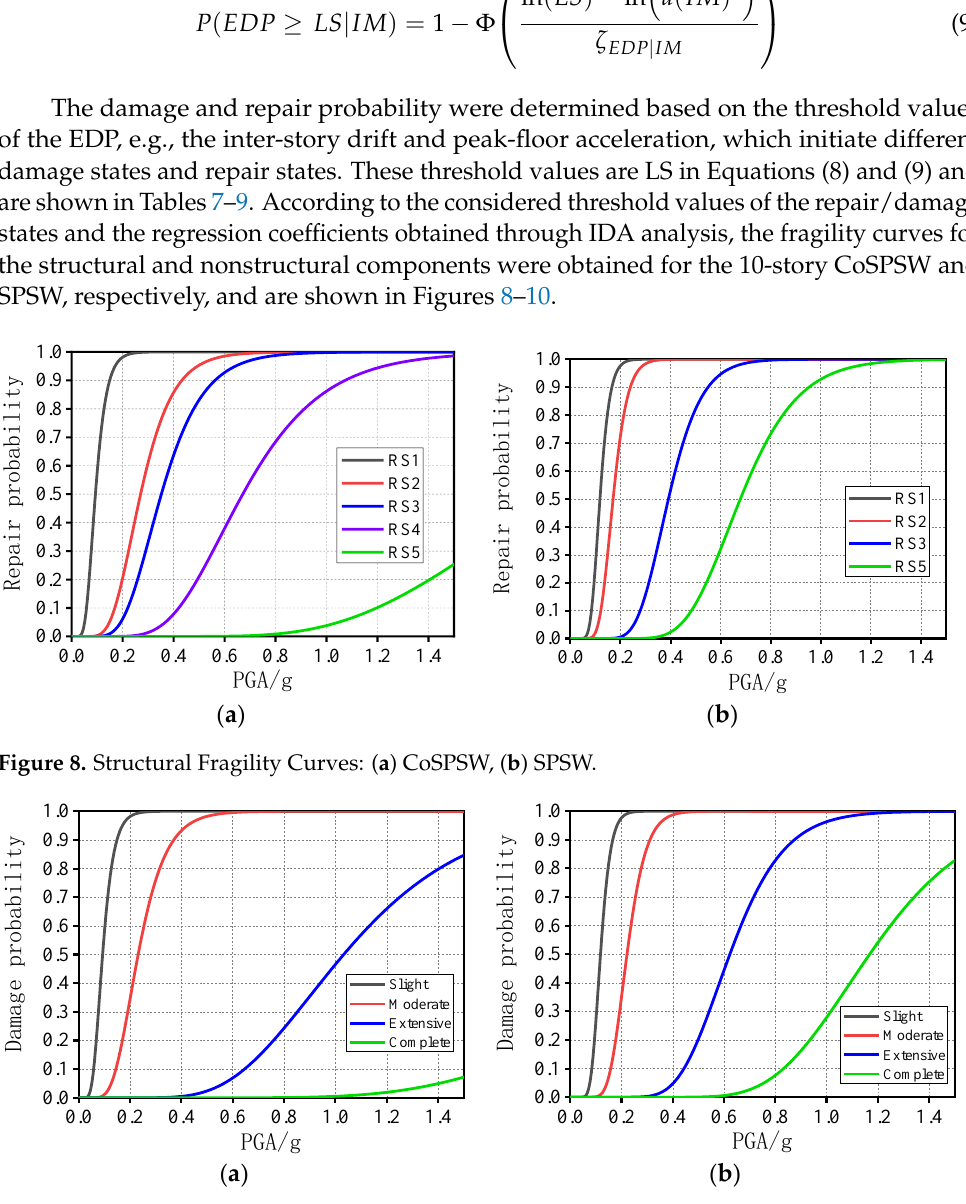
Figure 9. Drift-sensitive nonstructural components fragility curves: ( a ) CoSPSW, ( b ) SPSW.